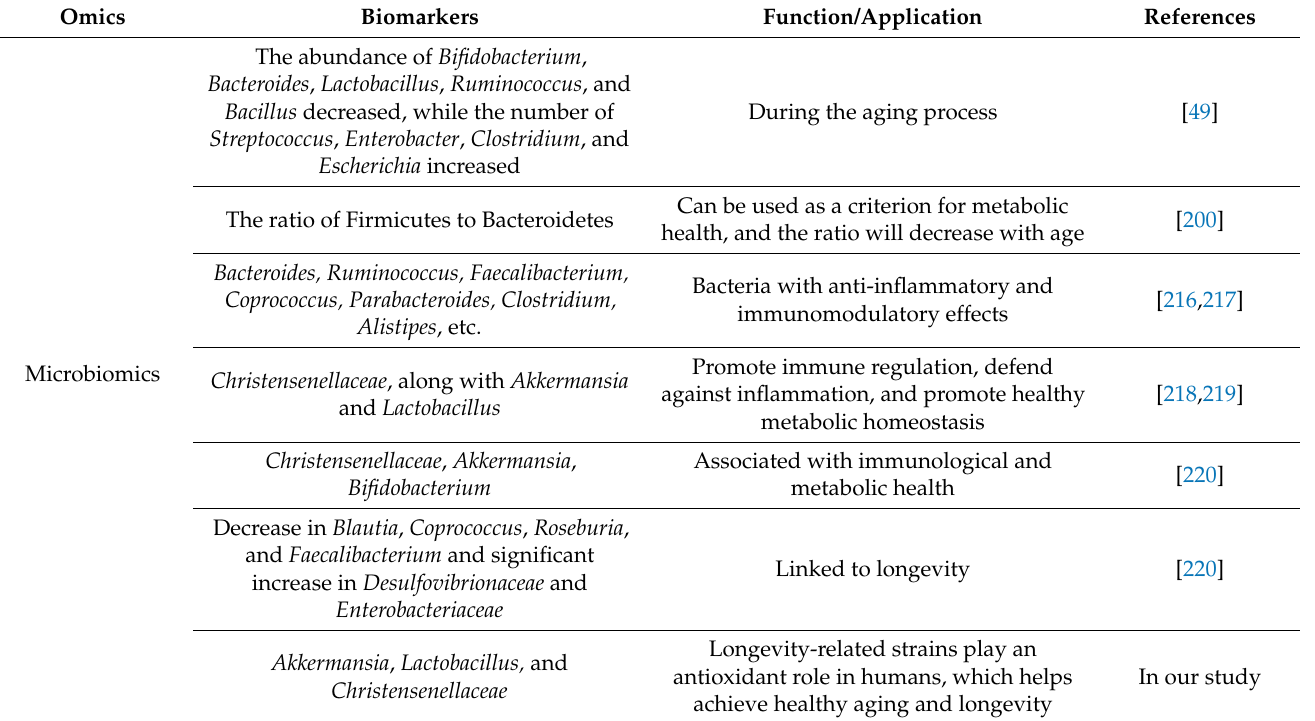
Table 5. Potential aging biomarkers identified in microbiomics